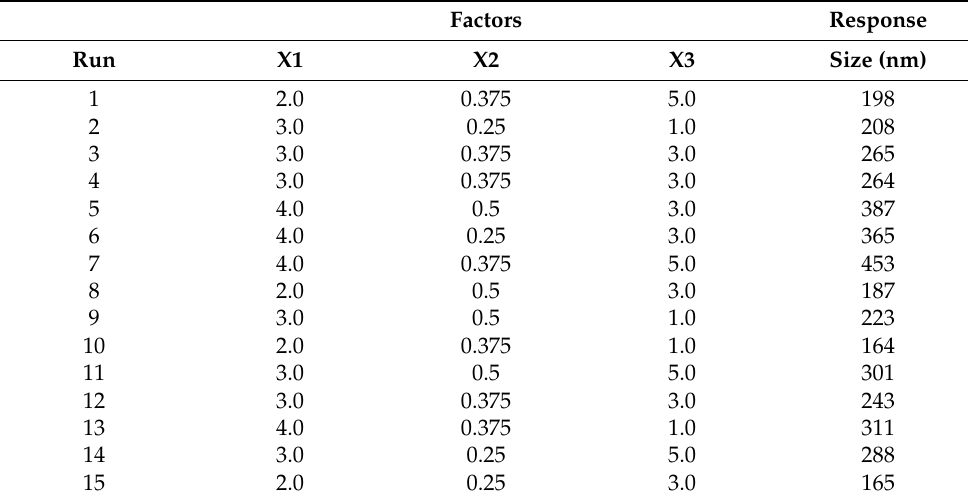
Table 1. The obtained particle size from various trials by Box-Behnken experimental design for the ICA-BM.